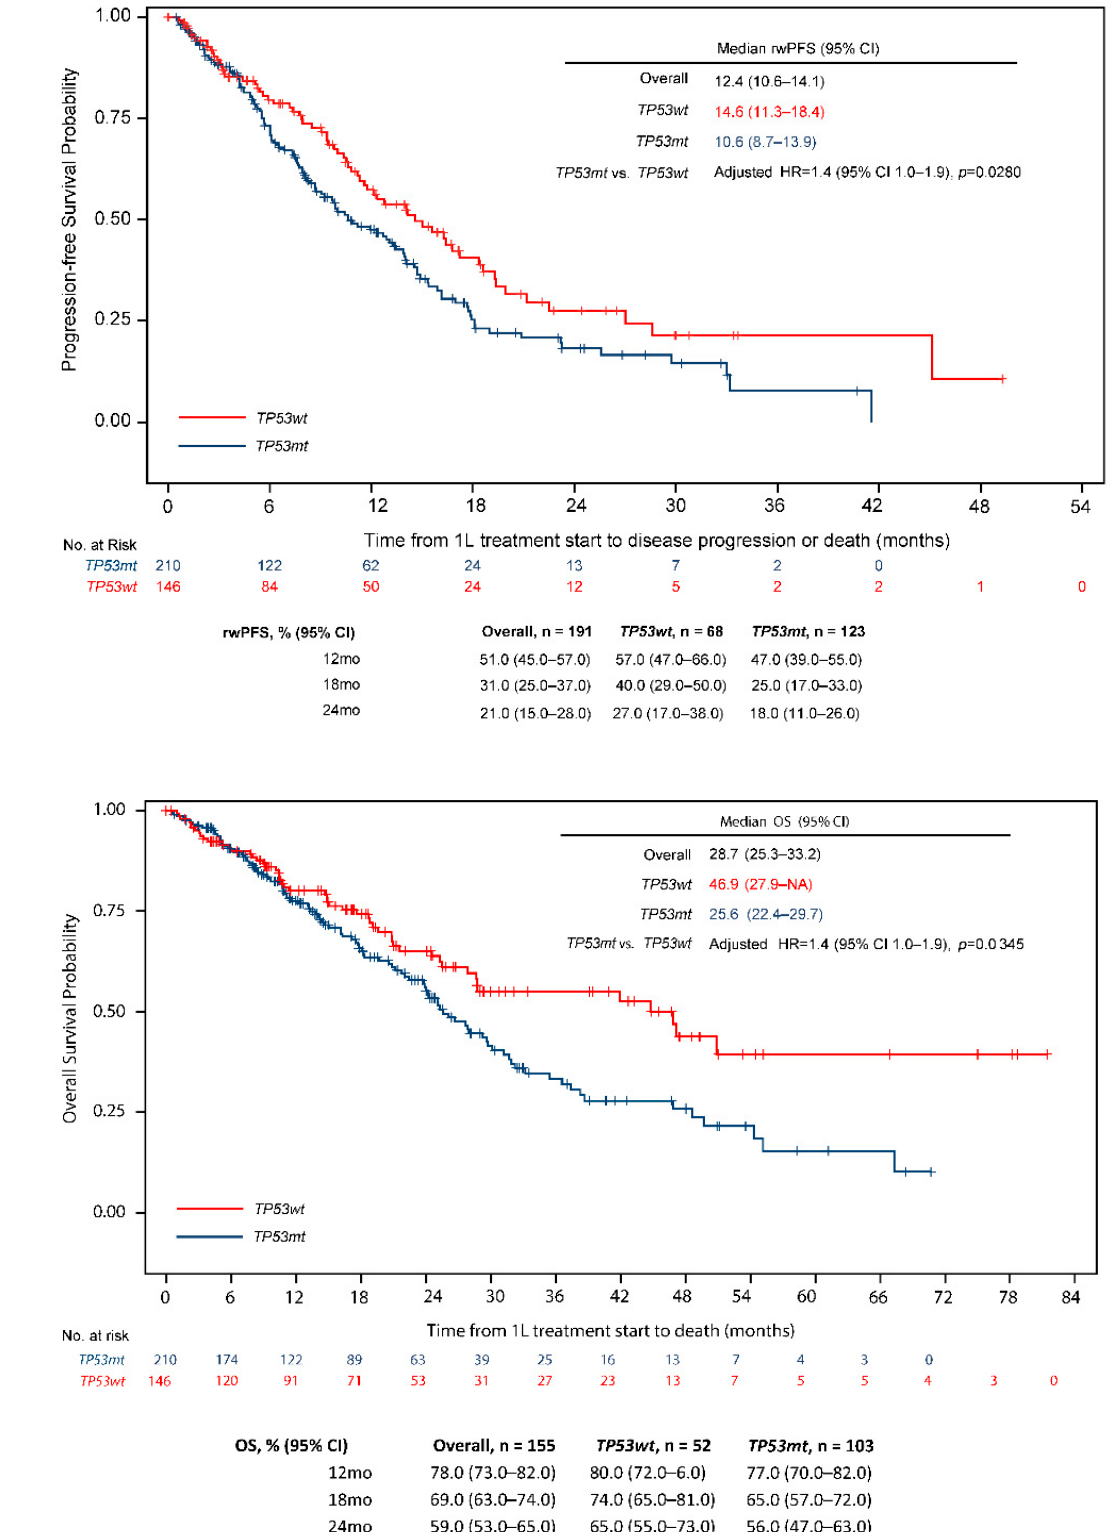
Figure 2. rwPFS and OS— TP53 co-mutation vs. TP53 wild-type. ( A ) rwPFS. ( B ) OS.CI = confidence Figure 2. r wPFS and OS— TP53 co ‐ mutation vs. TP53 wild ‐ type. ( A ) rwPFS. ( B ) OS.CI = confidence interval; HR = hazard ratio; OS = overall survival; rwPFS = real-world progression-free survival; TP53 mt = TP53 co-mutation; TP53 wt = TP53 wild-type. EGFR mutation includes both exon 19 and interval; HR = hazard ratio; OS = overall survival; rwPFS = real ‐ world progression ‐ free survival; exon 21 TP53 mt = TP53 co ‐ mutation; TP53 wt = TP53 wild ‐ type. EGFR mutation includes both exon 19 and exon 21 mutations.